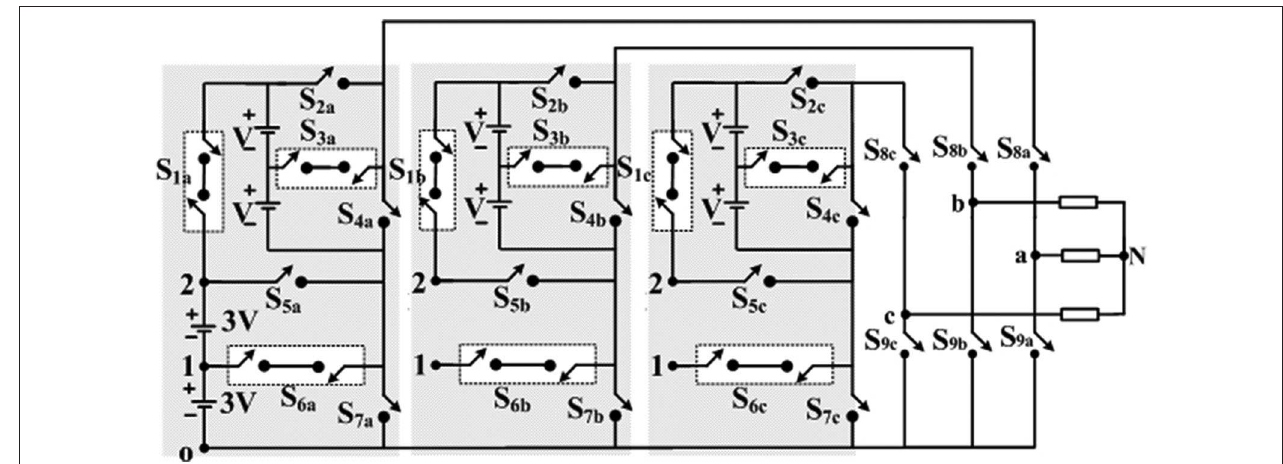
FIGURE 8 | The extended 3- φ seventeen level inverter topology (All the nodes marked ’1’ are connected, similarly all nodes marked ’2’ are connected).